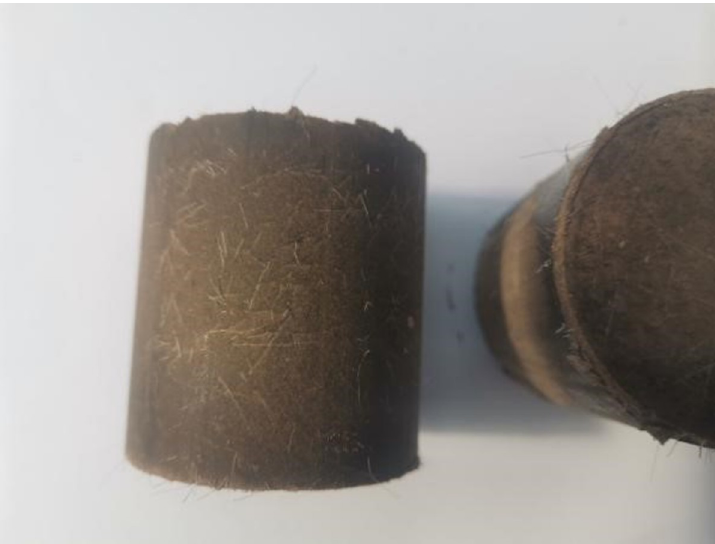
Fig 4. Prepared specimen of fiber stabilized carbide slag solidified soil. The size of the specimens were 50 mm in diameter, 50 mm in height, and the degree of compaction was 96%. After the specimens were produced using the static pressure method, they were placed in a curing box (temperature = 20 ± 2˚C; relative humidity � 95%).